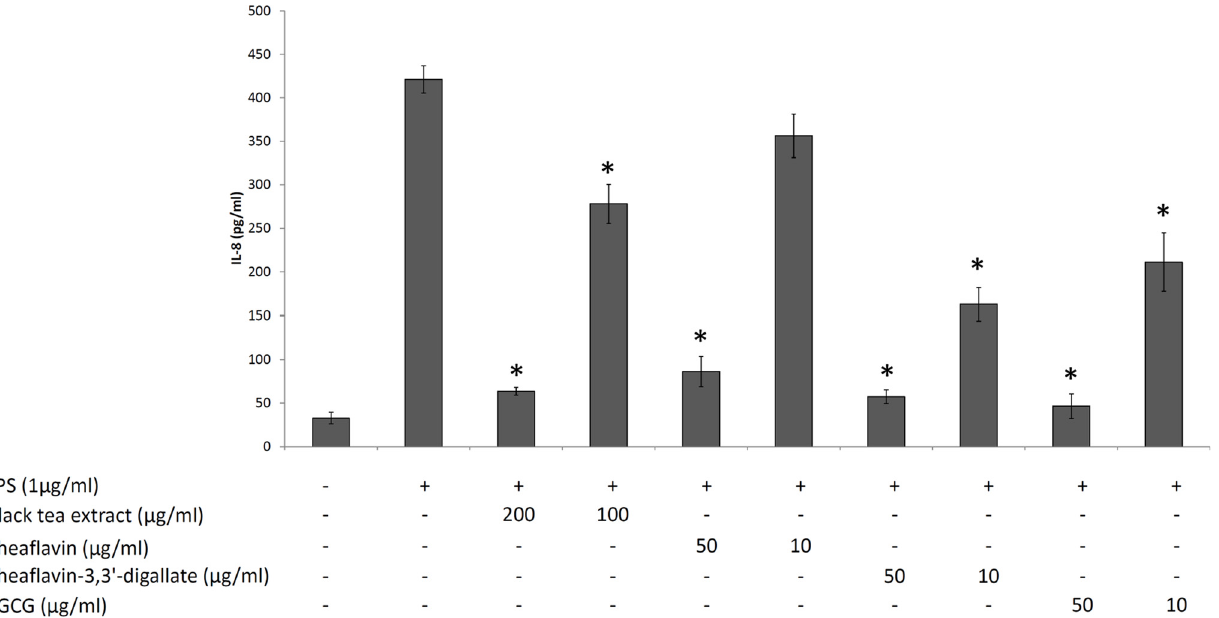
Fig 2. Effects of the black tea extract, theaflavin, theaflavin-3,3 ’ -digallate, and EGCG on the secretion of IL-8 by LPS-stimulated oral epithelial cells. * , significantly different from control (no compounds) at p < 0.01.